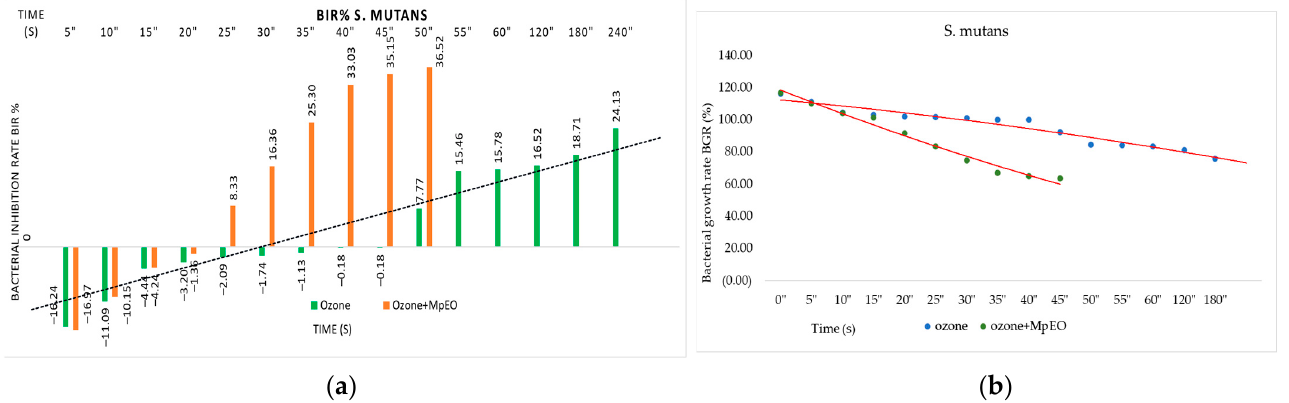
Figure 1. MpEO antimicrobial activity on the tested strains at different concentrations expressed as BIR%.